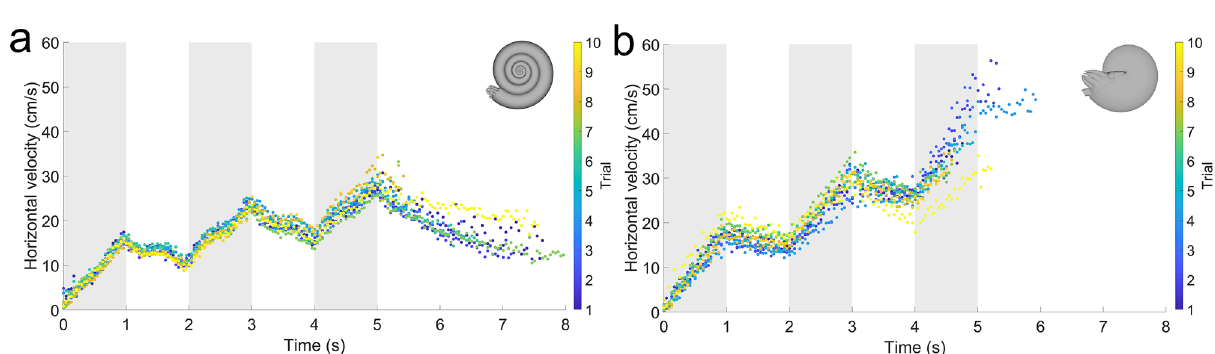
Figure 6. Velocities (horizontal components) for each model after initiating three, one-second jet pulses with one-second “refill” periods. ( a ) Serpenticone and ( b ) oxycone. Shaded regions denote the times the motor was active. Colors indicate the trial performed for each